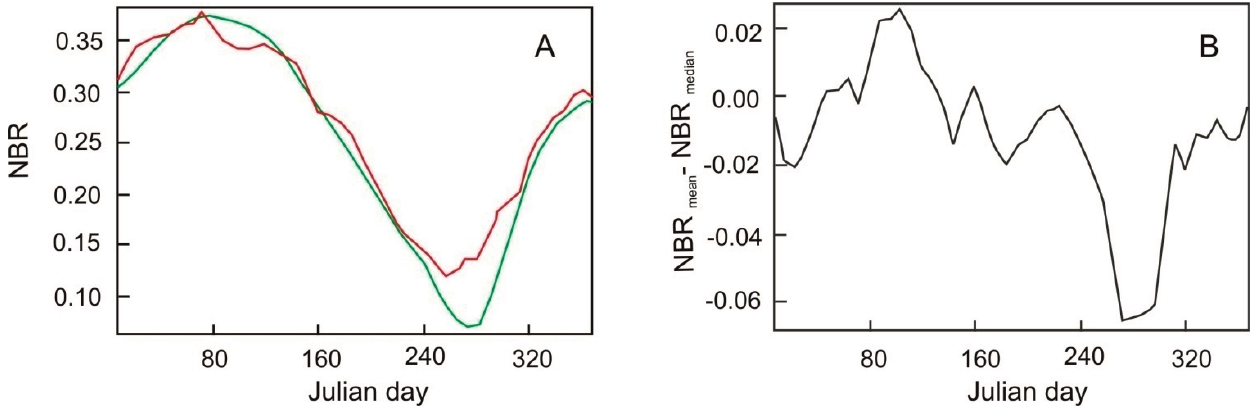
Figure 16. Comparison between the mean annual curve (green line) and ( A ) median annual curve (red line), and ( B ) difference curve (mean–median).